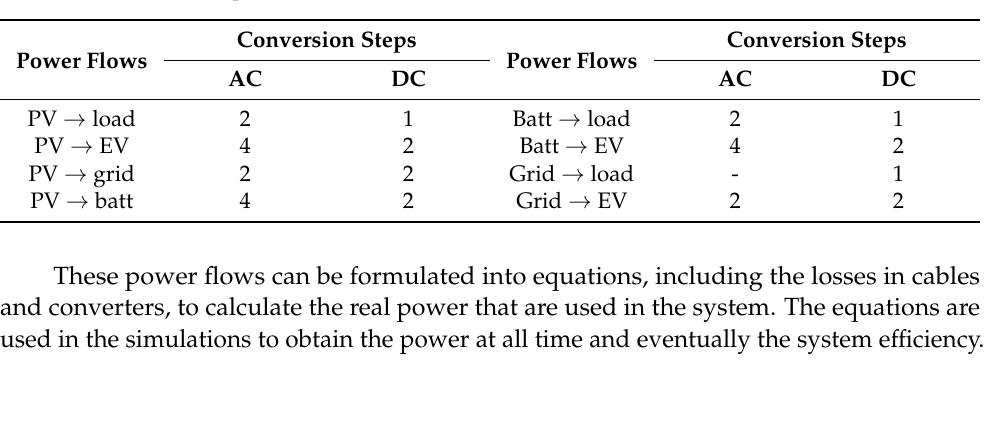
Table 1. Conversion